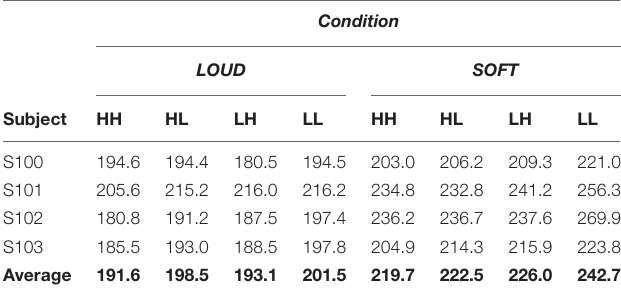
TABLE 3 | Mean RTs in ms for the two-tone (dual-target) stimuli in the two scenarios.